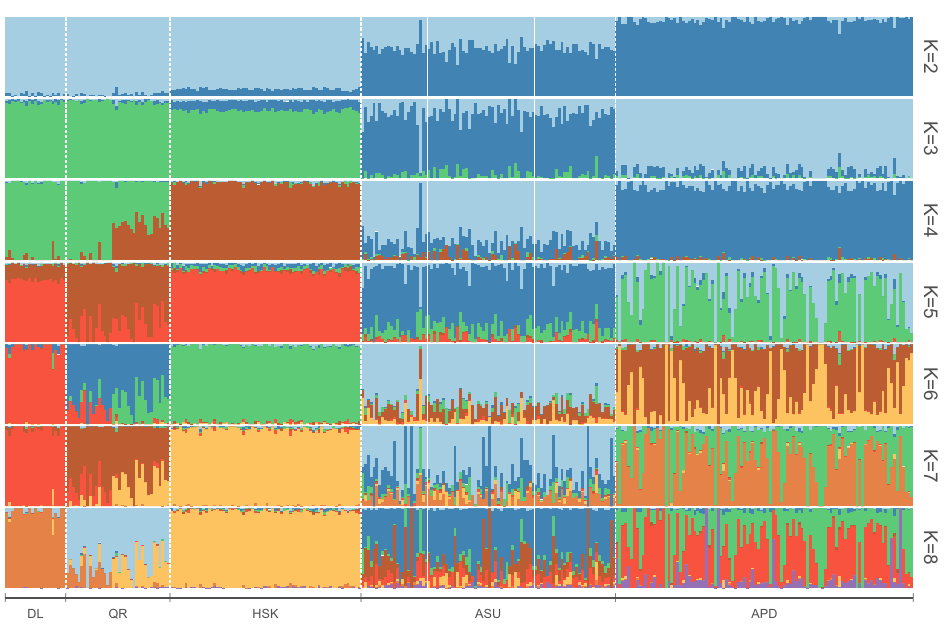
Figure 3. Admixture analysis of five sheep breeds. From left to right are DL, QR, HSK, ASU and